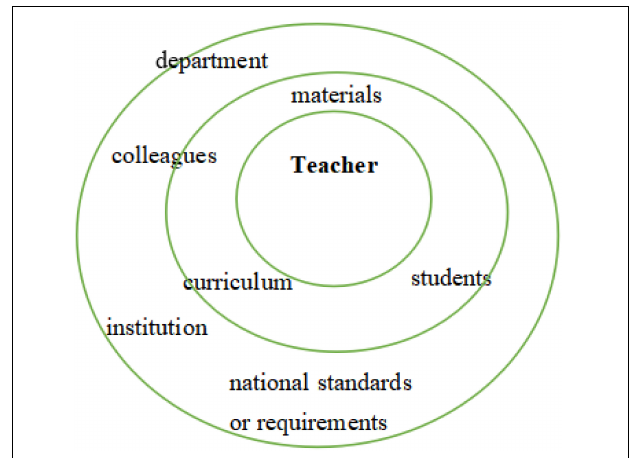
FIGURE 1 | Matrix of plural discourses enclosing the teacher.